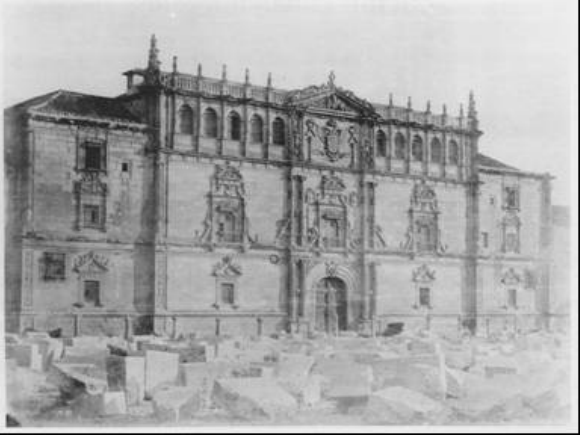
Figure 2: San Diego's square during the demolition of the San Diego's convent in 1859 for the new headquarters construction. Picture by J. Laurent, from the collection of J. F. Huerta. Afterwards, a new facade is built (over the original made of clay) by Rodrigo Gil de Hontañón between 1537 and 1553. It was always said that the stone came from Tamajón (Guadalajara), but recent researches (García, 2013), place the quarry in the Vellón village (Madrid), in some estates whose previous owner was the Cardinal Cisneros. The facade consists in one central module with three parts of height of which the upper part is set up by a gallery